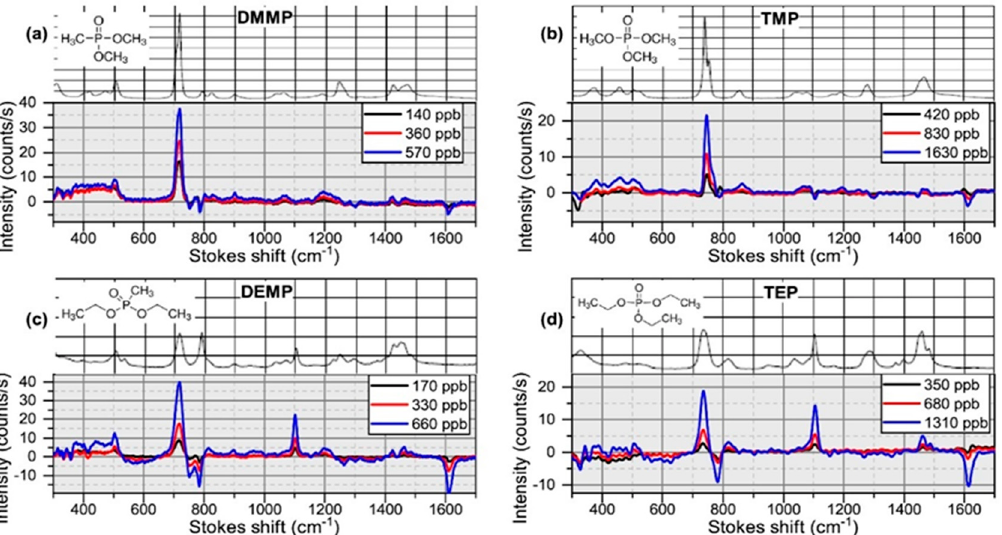
Figure 4. (Reprinted with permission from [50] © Optica) Background-subtracted WERS spectra of ( a ) DMMP, ( b ) TMP, ( c ) DEMP, and ( d ) TEP at different concentrations compared to their reference Raman spectra.